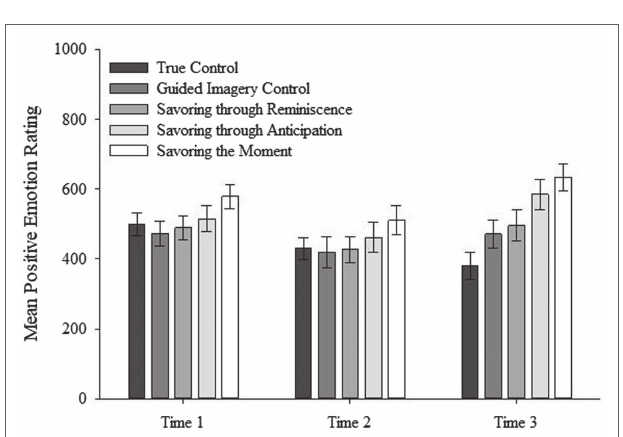
FIGURE 2 | Interaction effect between time and intervention on positive emotions. Errors bars represent standard errors of the mean.